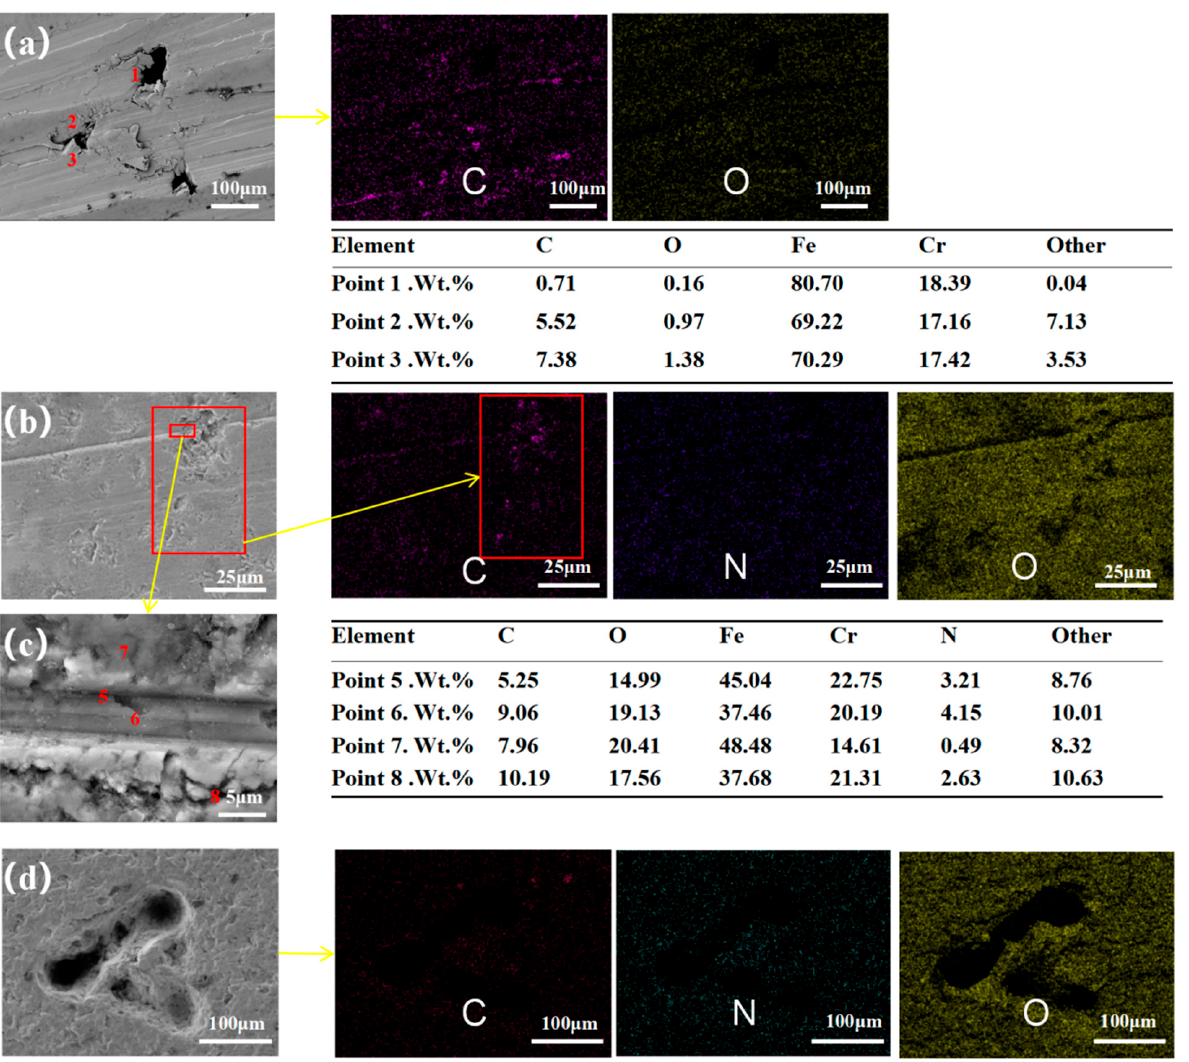
Figure 13. SEM image and EDS (point sweep and surface sweep) of the worn part of 4Cr10Si2Mo. ( a ) TA group. ( b , c ) NS group. ( d ) NA group.